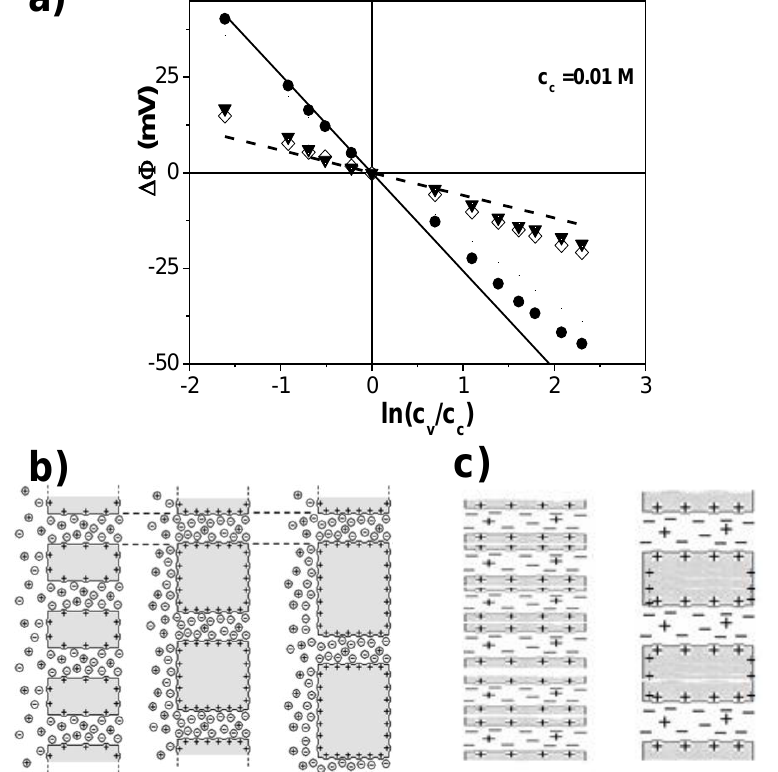
Figure 5. ( a ) Variation of ∆Φ values with concentration ratios for NPAS-Sf ( • ), NPAS-Ph ( (cid:72) ), and NPAS-And ( ♦ ). Dashed line: NaCl solution di ff usion potentials; solid line: ideal anion-exchanger (t − = 1 and t + = 0). Scheme of ions distribution in charged nanoporous structures as a function of ( b ) charge and porosity for samples with similar pore size; ( c ) pore size and porosity for samples with similar surface charge. Table 4. E ff ective fixed charge (X ef ), counter-ion transport number (t Cl − ), ionic di ff usion coe ffi